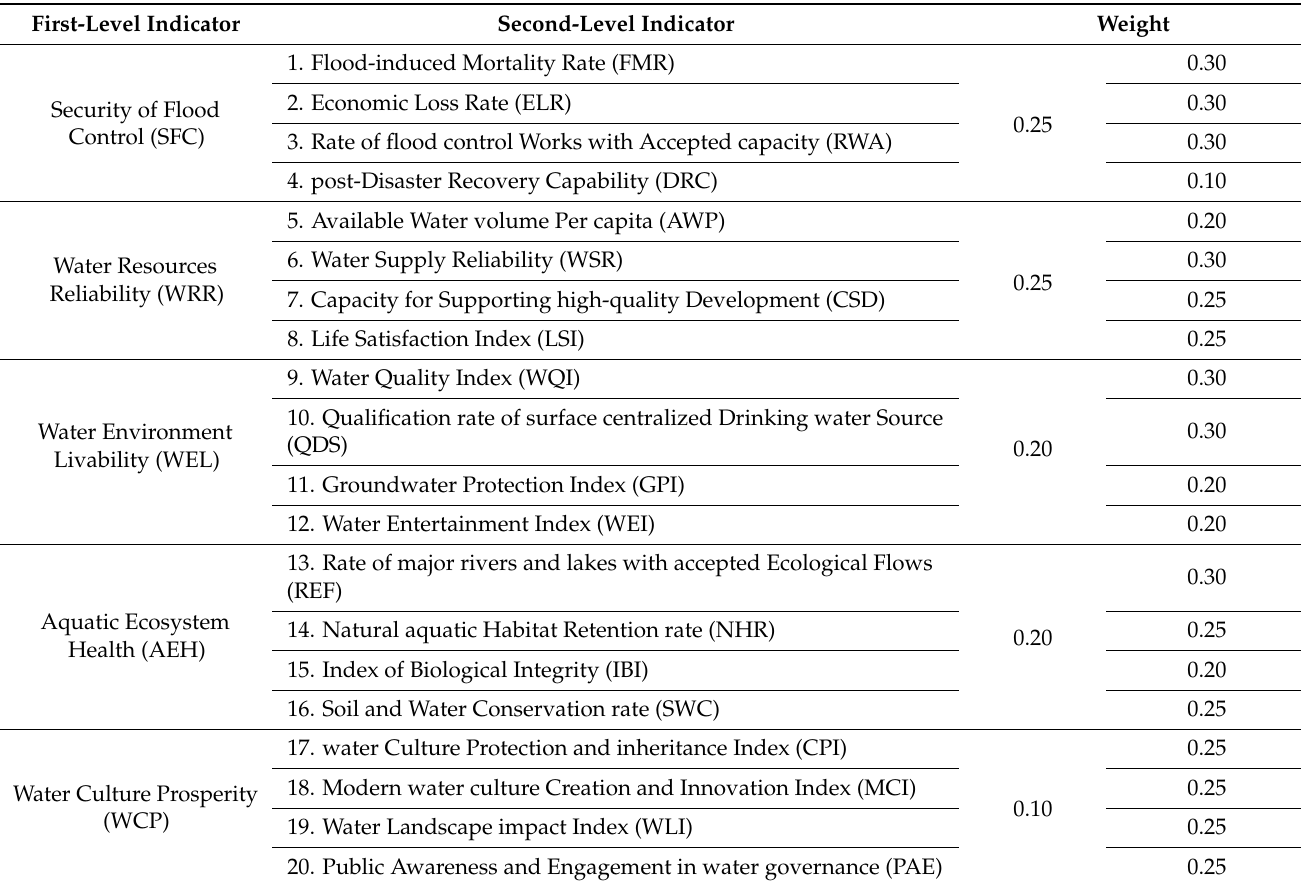
Table 6. Weights of first-level and second-level indicators of the RHI.